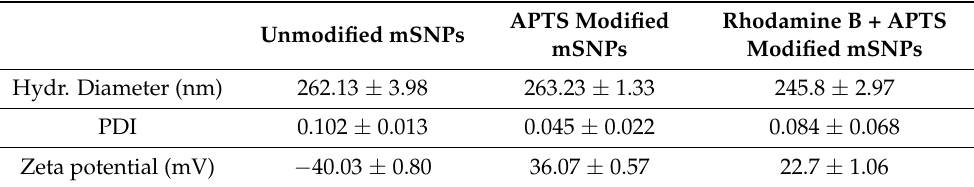
Table 1. Hydrodynamic diameter, PDI and zeta potential of the unmodified mSNPs, covalently bound APTS and with rhodamine B and APTS-modified mSNPs. The numbers presented show that APTS modification leads to a change of zeta potential from negative to positive values without influencing the hydrodynamic diameter.